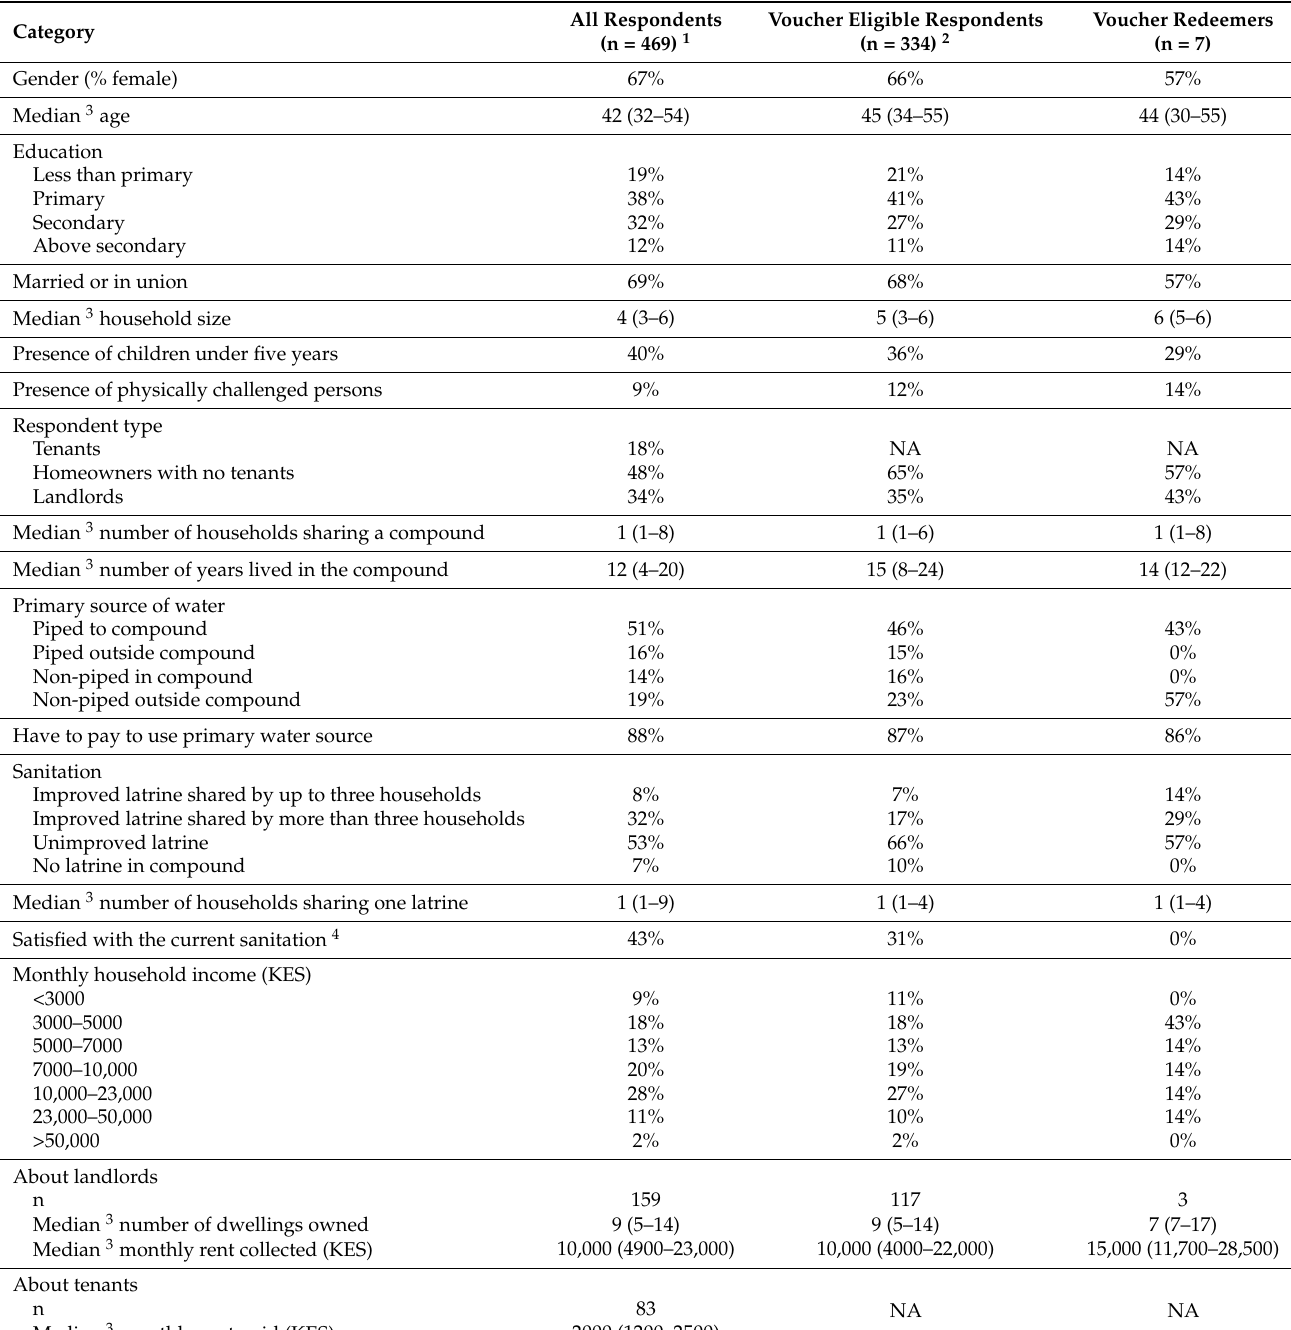
Table 2. Description of survey respondents, voucher eligible respondents, and voucher